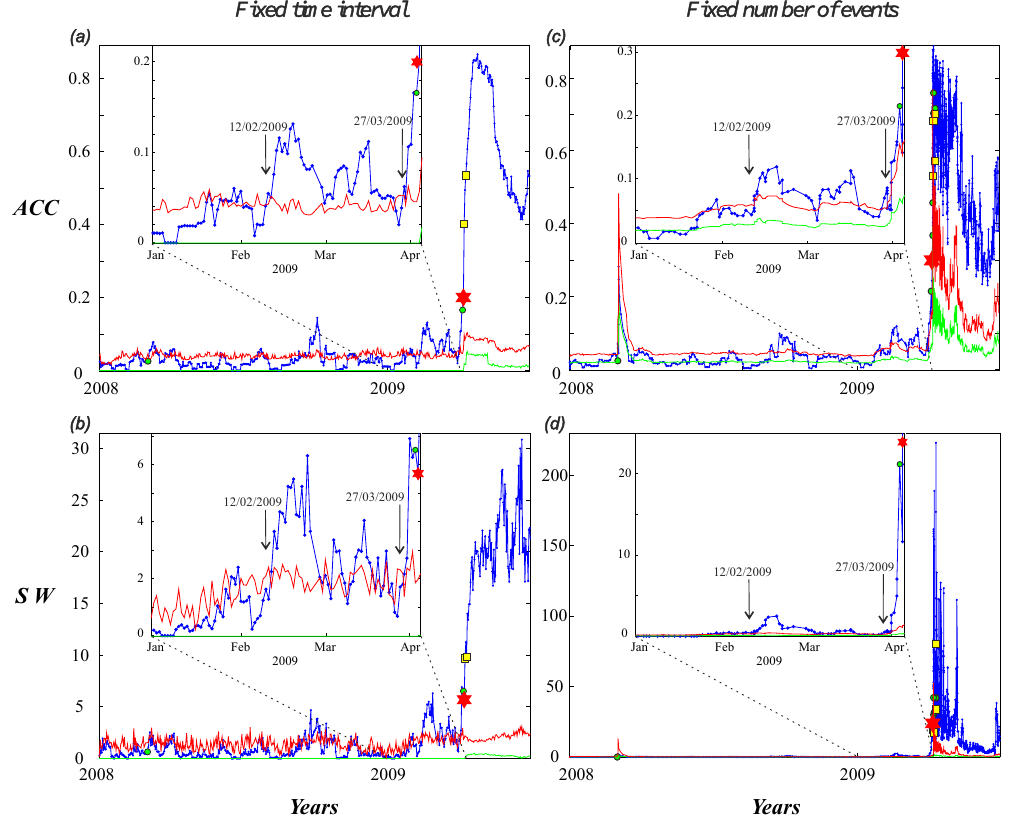
Figure 4. As in Fig. 3 for computations performed with radius R 2 = 3 ◦